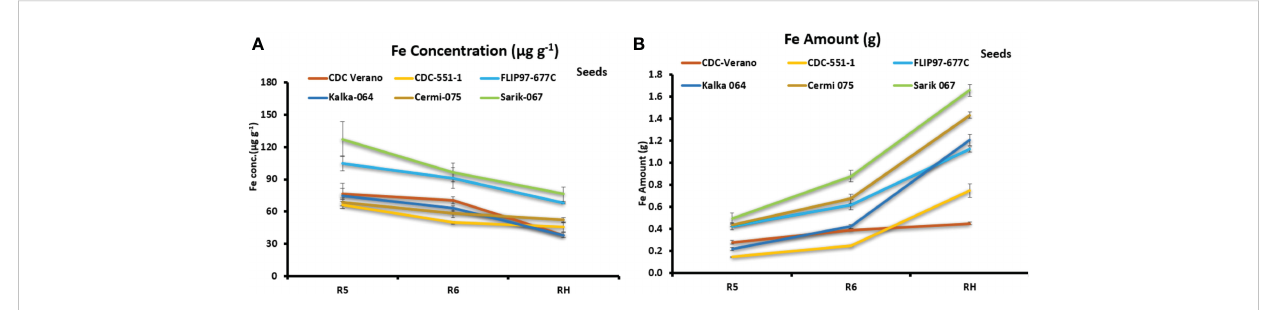
FIGURE 4 Mean Fe concentration (µg g -1 , ± SE, n = 8) (A) and mean Fe amount (g total seeds -1 plant -1 , ± SE, n = 8) (B) in seeds of six chickpea genotypes at R5, R6, and RH growth stages.